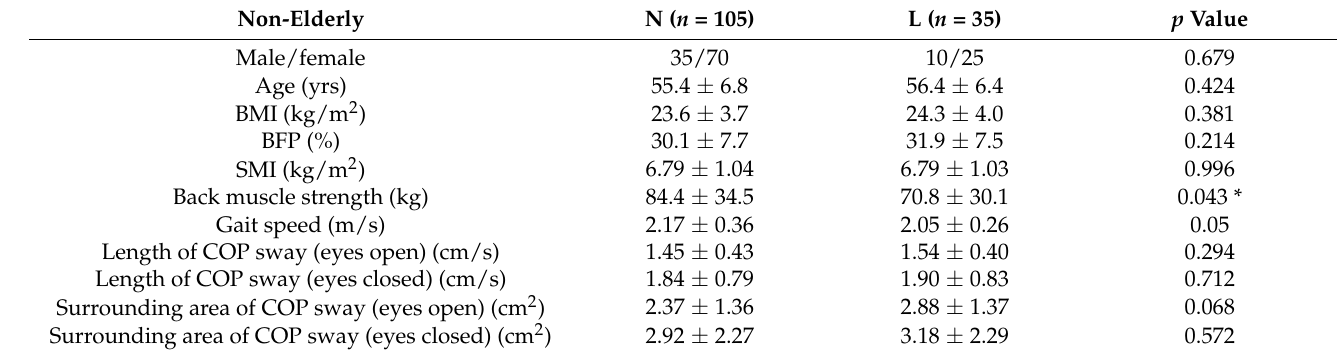
Table 2. Comparison of each parameter between the N and L groups in non-elderly participants.